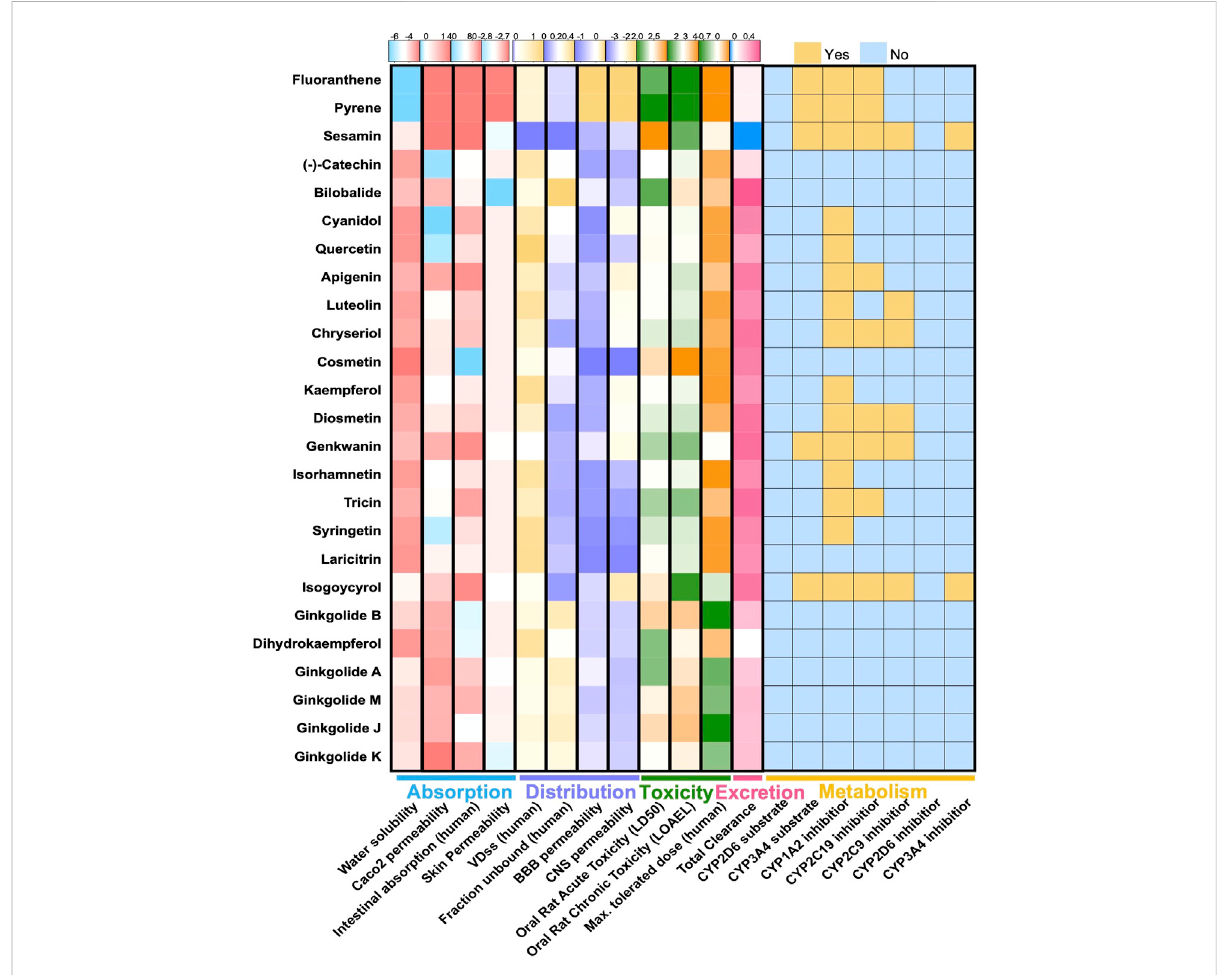
FIGURE 1 ADMET features of 26 compounds in GBE. Heatmaps showed pharmacokinetic parameters of two components in GBE, including parameters describing drug absorption, distribution, metabolism, excretion, and